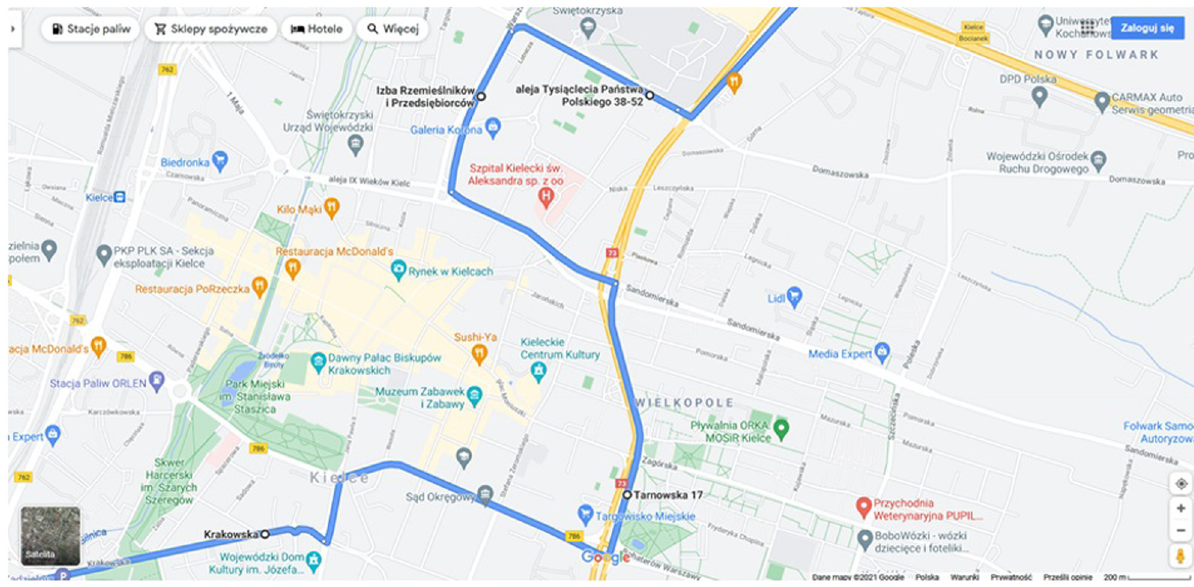
Figure 2: A fragment of the planned research route, taking into account the drive through the city of Kielce.